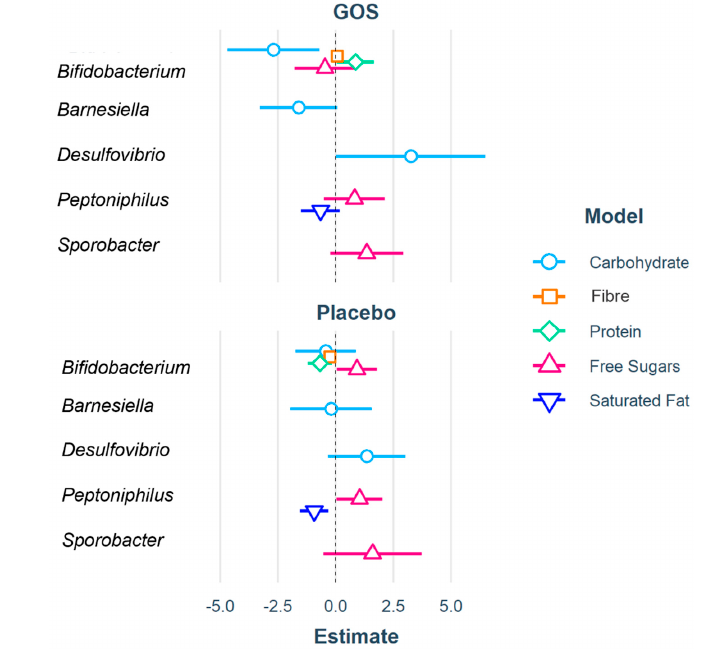
Figure 2. Coefficients from significant stepwise regressions for each nutrient model (carbohydrate, fibre, protein, free sugars, and saturated fat), represented by different colors and point shapes. Only genera which had a significant contribution on model outcomes are plotted. Treatment groups (GOS and Placebo) are plotted separately for ease of viewing. The further the data point from central zero the larger the coefficient and strength of effect. Data points to the left of zero are negative coefficients, illustrating a negative relationship of the predictor to nutrient outcome, and data point to the right are positive coefficients, representing a positive relationship. In the carbohydrate model (blue), GOS Bifidobacterium and Desulfovibrio are significant coefficients. In the Fibre model (orange), placebo Bifidobacterium is a significant coefficient. The Protein model (green) found GOS Bifidobacterium a positive significant coefficient and placebo Bifidobacterium a negative significant coefficient. The free sugar model (pink) found placebo Bifidobacterium and Peptoniphilus to be significant coefficients and in the saturated fat model (dark blue) placebo Peptoniphilus a negative significant coefficient.